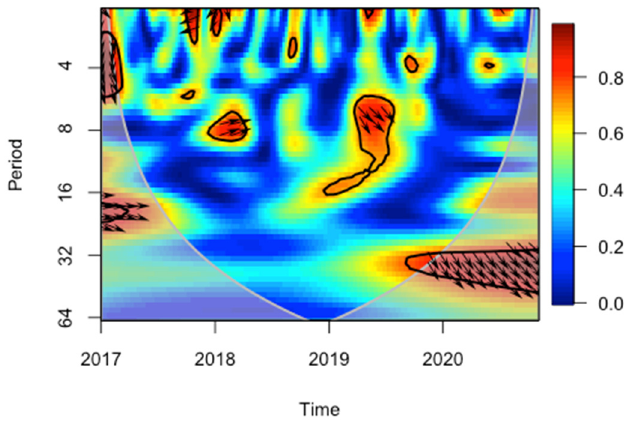
Panel C . Wavelet coherence: Decentraland attention and Bitcoin returns Figure 1. This figure represents the wavelet coherence analysis for Bitcoin returns and NFT levels of attention (Panel A ), Bitcoin returns and CryptoPunk attention (Panel B ), and Bitcoin returns and Decentraland attention (Panel C ). Correlation is shown by the colour—hotter colours (cool blue to hot red) indicate higher absolute correlations. For the arrows, → shows positive correlation, ← shows negative correlation, ↗ and ↙ show Bitcoin leads the NFT, and ↘ and ↖ show the NFT leads Bitcoin. We use weekly Bitcoin returns and Google search activity between 1 December 2017 and 30 July 2021.